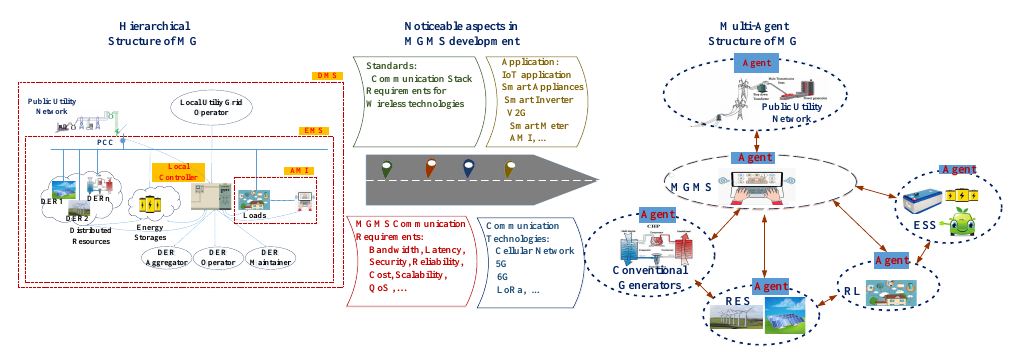
Figure 4. Basis of MGMS